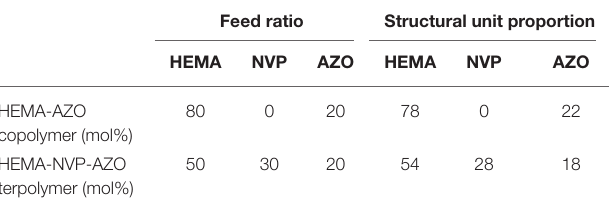
TABLE 1 | The feed ratio and structural information for copolymers. Feed